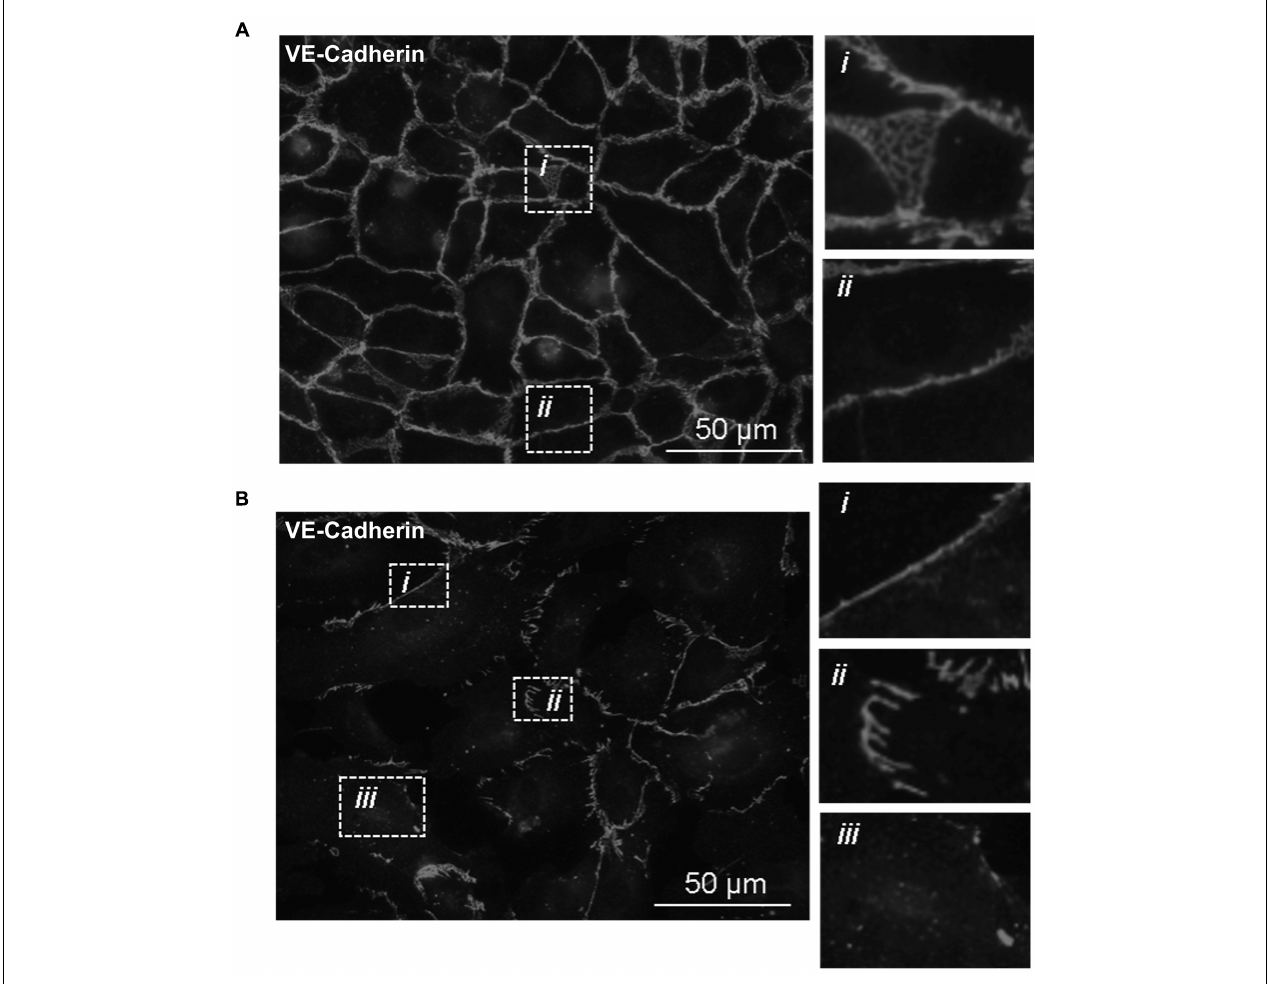
FIGURE 3 | Recombinant Tp0751 disrupts endothelial VE-cadherin intercellular junctions. Immunofluorescence evaluation of the distribution of the adherens junction protein VE-cadherin in human umbilical vein endothelial cells (HUVECs) following a 30-min co-incubation with 25 µ M of recombinant protein. Shown are representative immunofluorescence images of permeabilized endothelial cells stained with mouse anti-VE-cadherin and goat anti-mouse (Alexa 568-conjugated) from three independent experiments obtained from a Nikon 80i fluorescence microscope at × 400 magnification. Insets reveal specific junctional architecture. (A) HUVECs treated with negative control recombinant Tp0327 (I23-S172) where insets reveal ( i ) VE-cadherin plaque-like junctional structure and ( ii ) linear (continuous) junctions. (B) HUVECs treated with recombinant Tp0751 (V99-P237) where insets reveal ( i ) linear (continuous) junctions, ( ii ) disrupted (discontinuous) junctions, and (iii ) intracellular VE-cadherin.